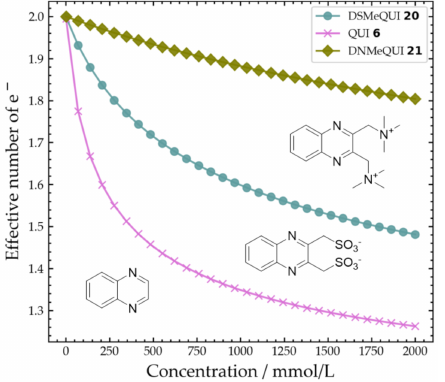
Figure 11. Effective number of electrons (e − ) predicted as a function of the total concentration of the monomer for the three different quinoxalines ( 6 , 20 , and 21 ). The predictions are made based on Equations (2) and (3) and obtained aggregation